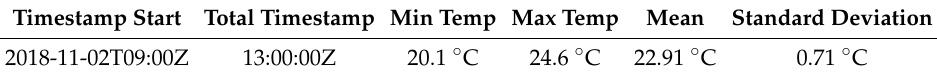
Table 3. Statistical table of measurements of the IoT nodes.